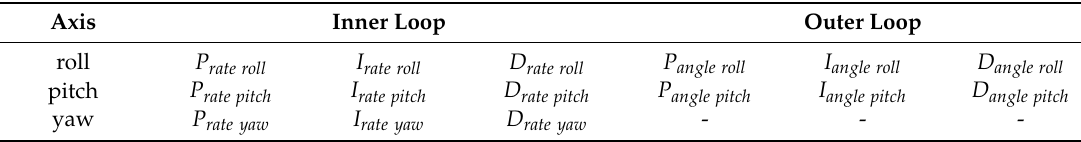
Table 1. Full set of control loop adjustable